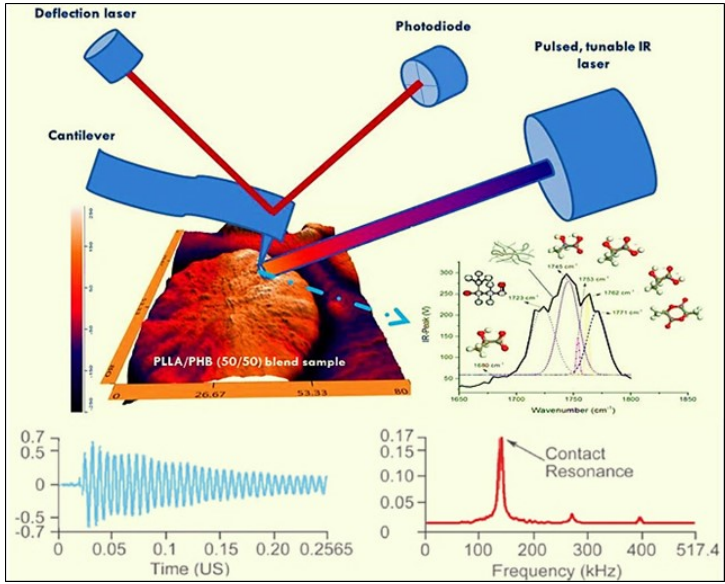
Figure 4. Principle of AFM-IR technique. Insert image shows an example of carbonyl groups of the blends of polyhydroxy butyrate and polylactide acid (50/50). This figure is designed by the